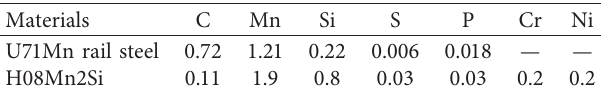
Table 1: Chemical composition of rail steel and welding wire (wt %).